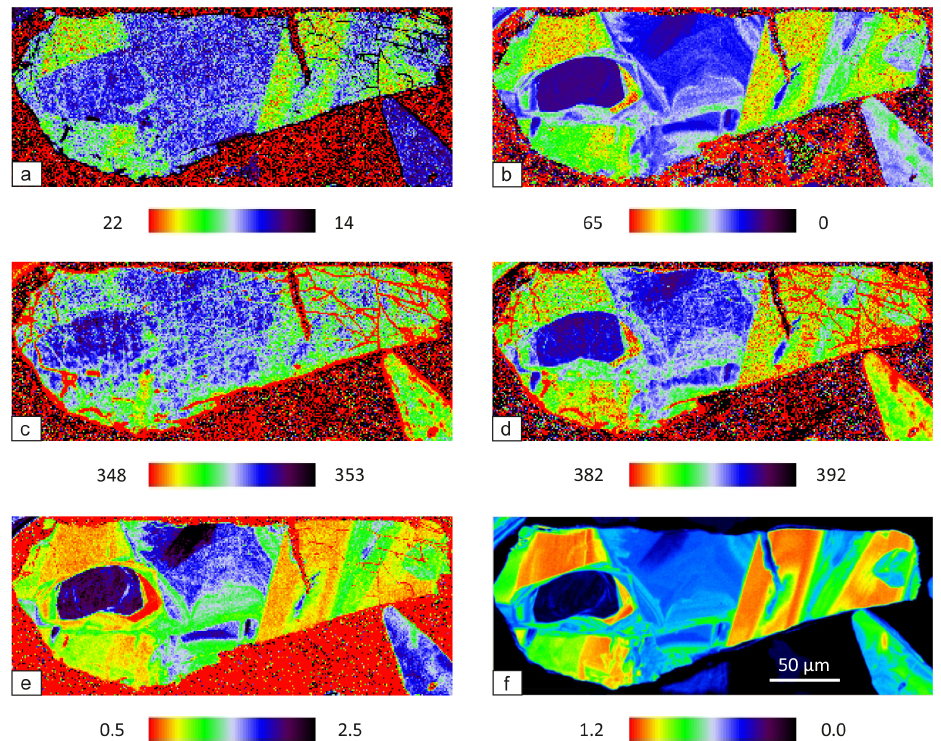
Figure 4. Raman map of pyrite grain with 633nm laser. FWHM of E g (a) and A g (b) modes (presented in cm − 1 ), Raman shift of E g (c) and A g (d) modes (presented in cm − 1 ), intensity ratio of E g and A g (A g / E g ) modes (e) , and Co distribution map revealed by EPMA (presented in at.%) (f)